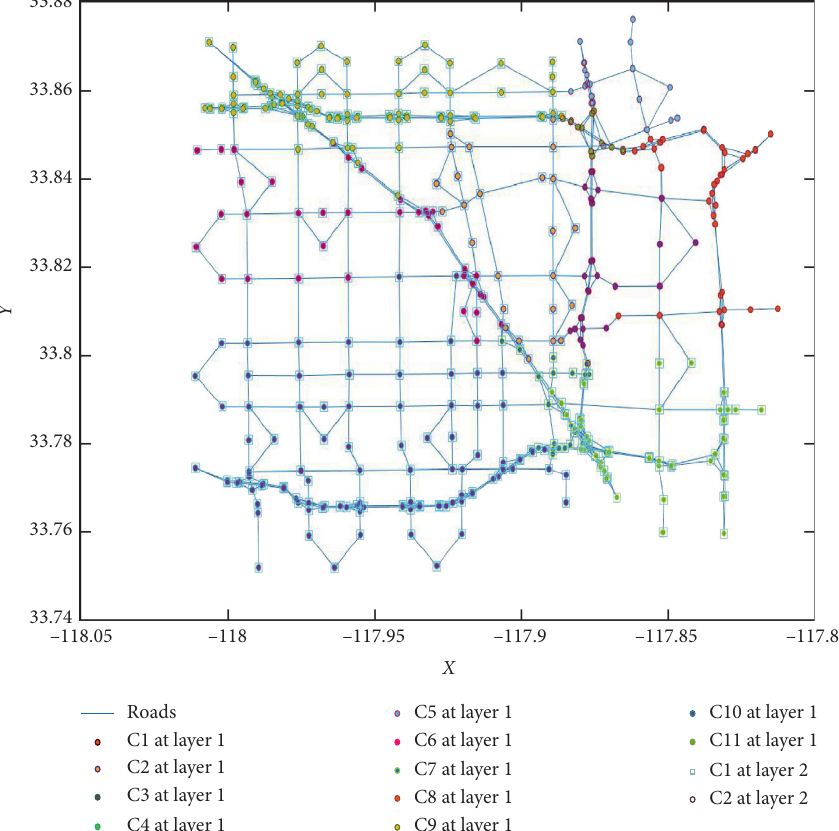
Figure 14: Communities and hierarchies of the Anaheim network plotted by MATLAB.